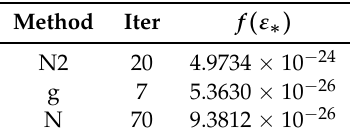
Table 5. Comparison between different approach to the outer iteration. The table show the number of iterations done by each method and the optimal values of the cost function.